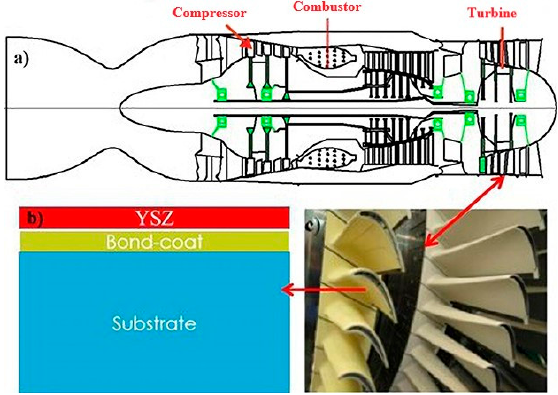
Figure 1. Hot-section component model of thermal barrier coatings. ( a ) The interior appointments of the turbine; ( b ) Yttria stabilized zirconia (YSZ) thermal barrier coatings; ( c ) thermal barrier coatings (TBC) coated on the turbine blade. Adapted with permission from [13]; Copyright 2016 Elsevier.